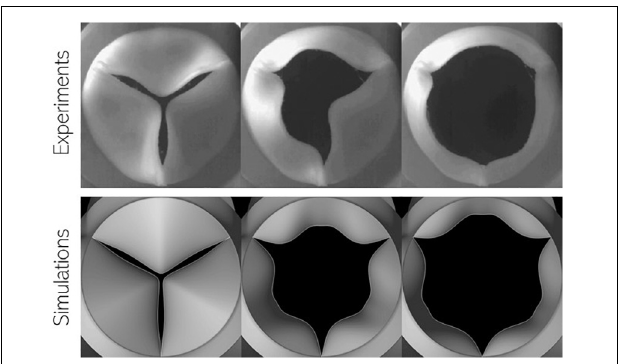
FIGURE 4 | Comparison of valve configuration at three instances during leaflet opening using (top) high-speed imaging of in vitro experiments using bioprosthetic valves and (bottom) present